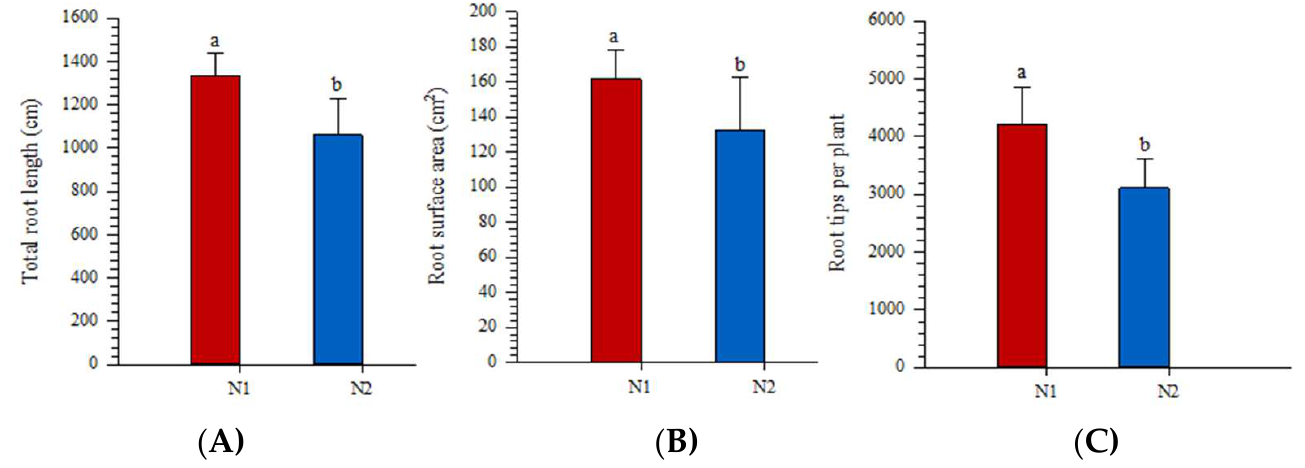
Figure 4. Effects of N addition on total root length ( A ), root surface area ( B ) and root tips ( C ). Bars with the same letters were not significantly different ( p > 0.05) using Tukey’s test. Error bars indicate standard error of means. N1 = 15 mg N/kg, N2 = 120 mg N/kg.